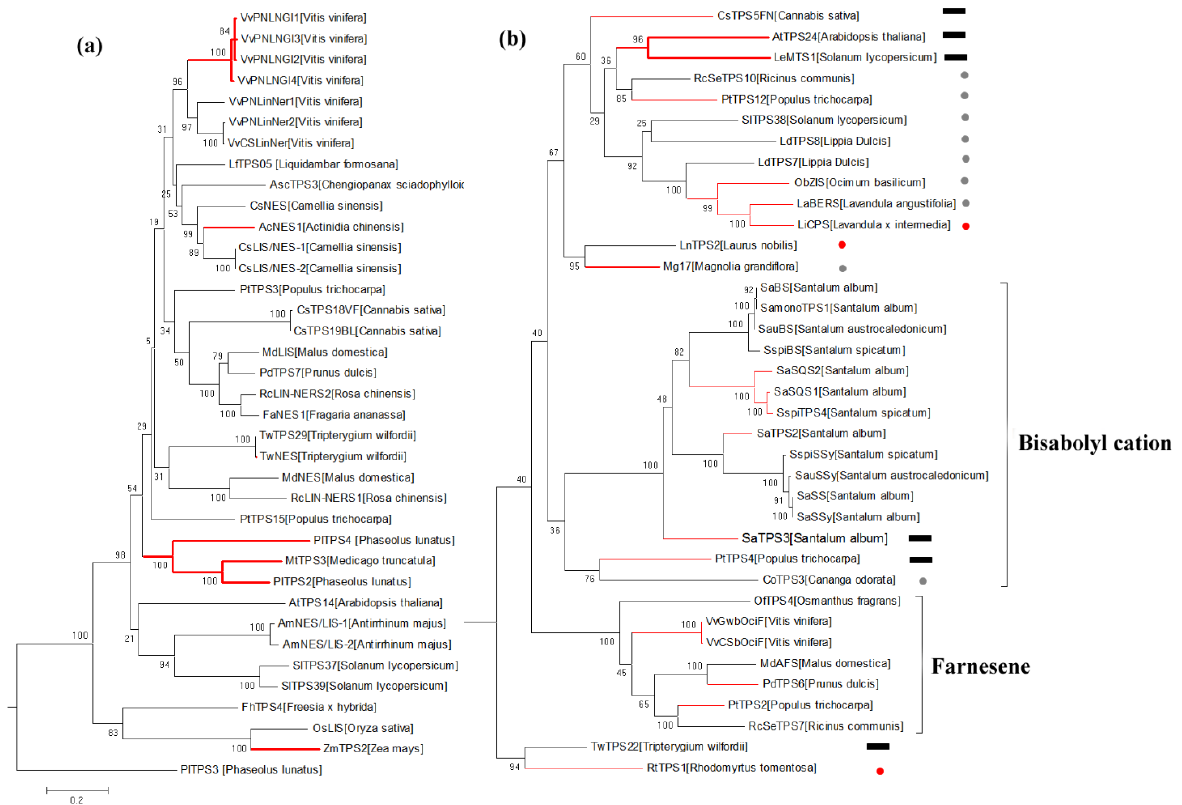
Figure 6. ( a ) The phylogeny of spermatophyte STSs in the TPS-g subfamily. STSs with diterpene synthases function in vitro are shown by red branches and uniformly distributed in the phylogenetic tree. ( b ) The phylogeny of spermatophyte STSs in the TPS-b subfamily. STSs with monoterpene synthases function in vitro are shown by red branches. STSs producing 1,6-cyclized sesquiterpenes and 1,10/1,11-cyclized sesquiterpenes are marked with grey dots and red dots, respectively. Products of STSs marked with black rectangles are acyclic farnesene or nerolidol.